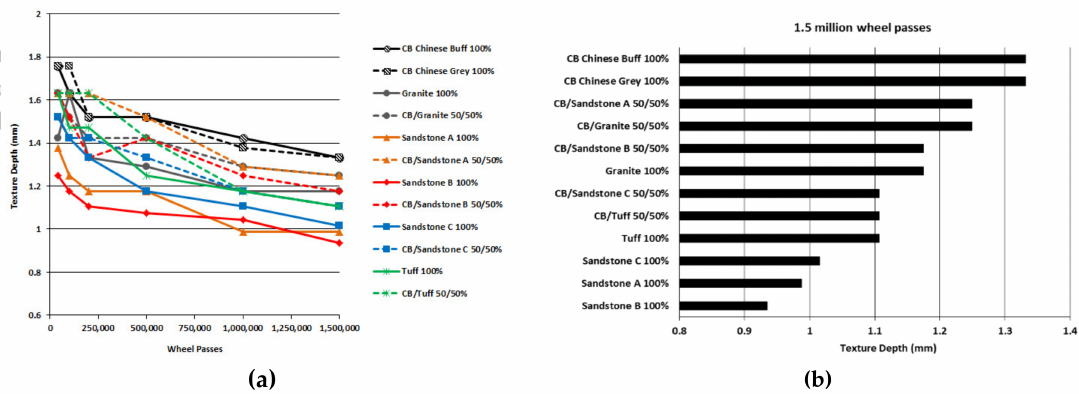
Figure 4. ( a ) Texture depth development up to 1.5 million wheel-passes; ( b ) Texture depth ranking after 1.5 million wheel-passes (Aetec data).